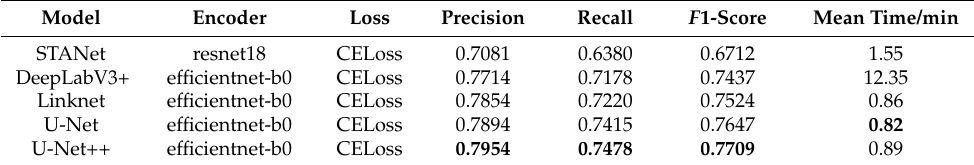
Table 3. Accuracy metric of each model on the test